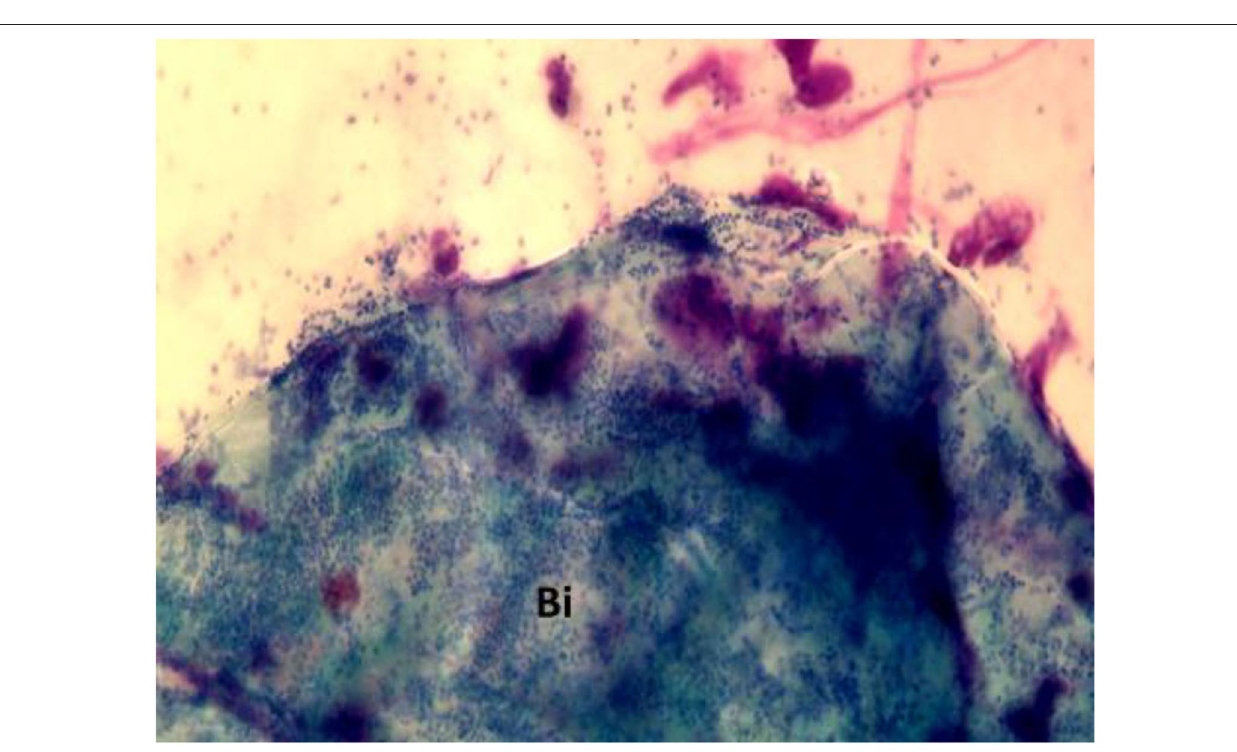
Frontiers in Allergy |